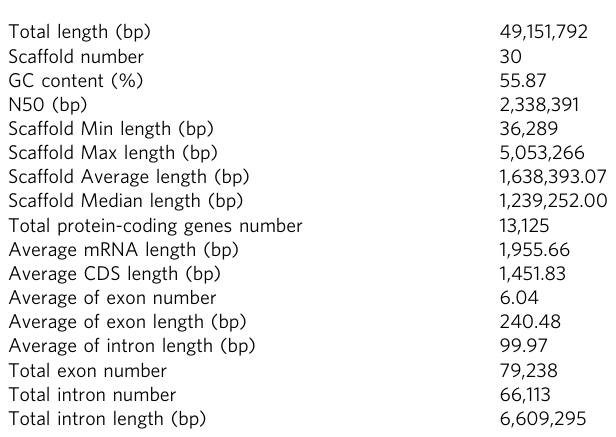
Table 1 General characteristics of the G. lingzhi